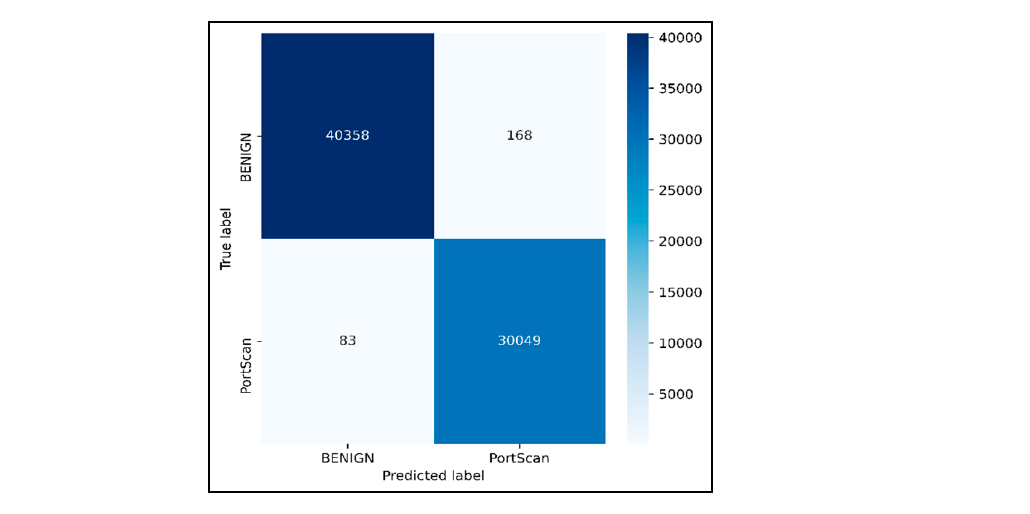
Figure 13. Friday afternoon-DDoS confusion matrix.